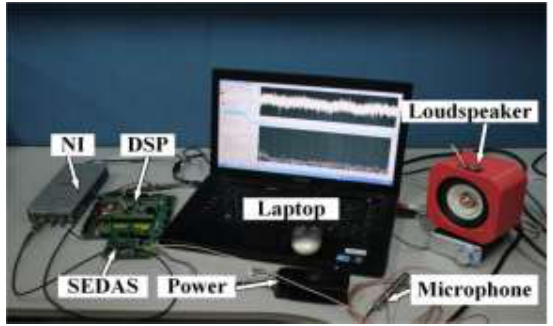
Figure 11. Experimental setups to validate the effectiveness of the ODEE method in the embedded system.